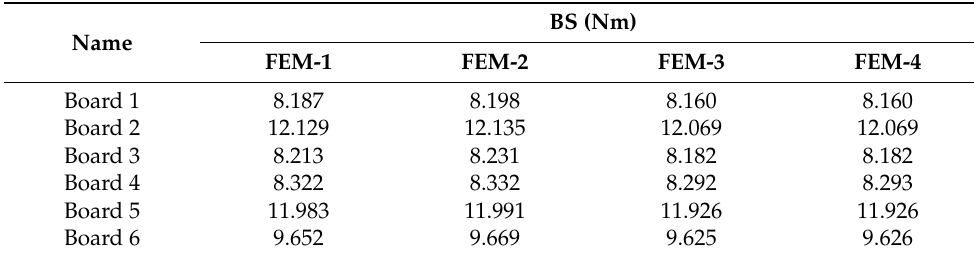
Table 4. The bending stiffness computed by the numerical model with included fluting with differ- ent number of periods. FEM-2–a model with two periods (see Figure 9a), FEM-4–a model with four periods (see Figure 9b).